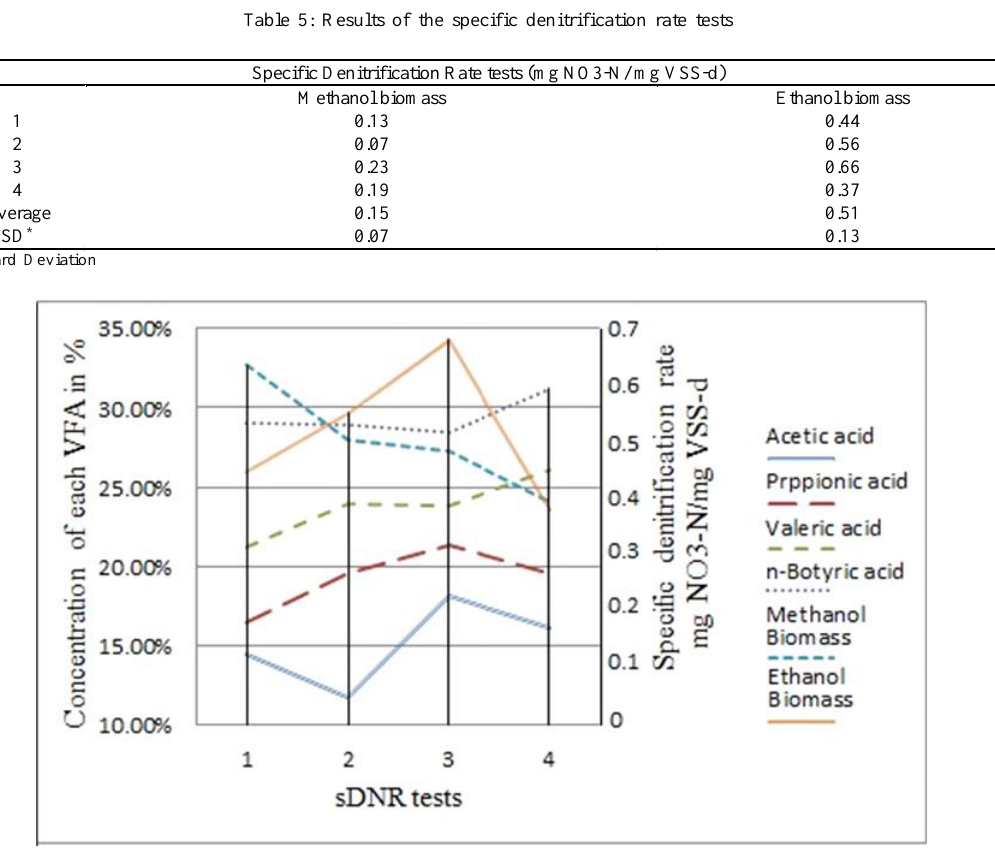
Fig. 2: sDNR results and VFA speciation in the supplemental carbon